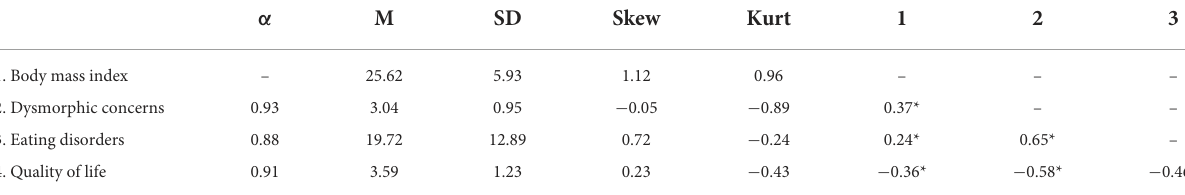
TABLE 2 Descriptive analysis and correlations.